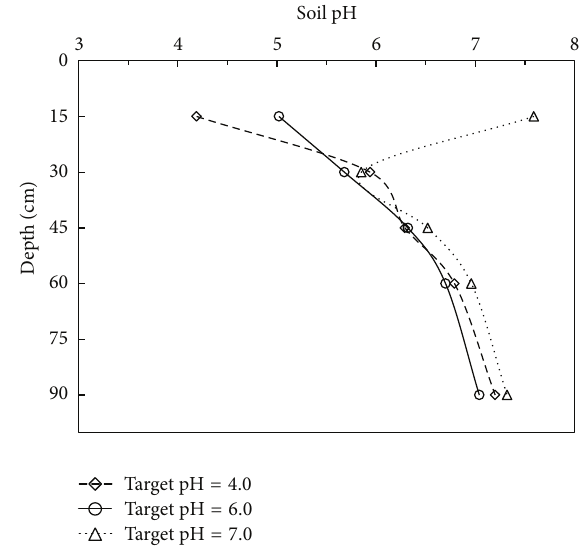
Figure 2: Effect of soil amendments on soil profile pH at Lahoma, Oklahoma, in 2010 for target pH of 4.0, 6.0, and 7.0. Initial soil pH on the top 15cm soil in 2009 prior to soil amendments application was